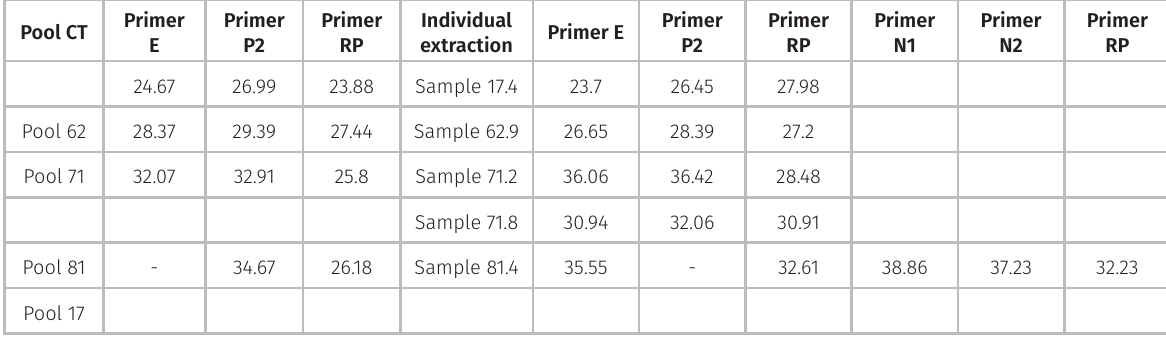
Table I. SARS-CoV-2 pool RT-qPCR analysis. Positive or undetermined pools. 81 pools containing 6 to 10 samples each were analyzed. Pools 17, 62 and 71 were positive and pool 81 was initially considered undetermined (-). The 37 samples were individually processed, and the positive results are described in Table 1B. Pool 81 was only considered positive after N1 and N2 genes were targeted by